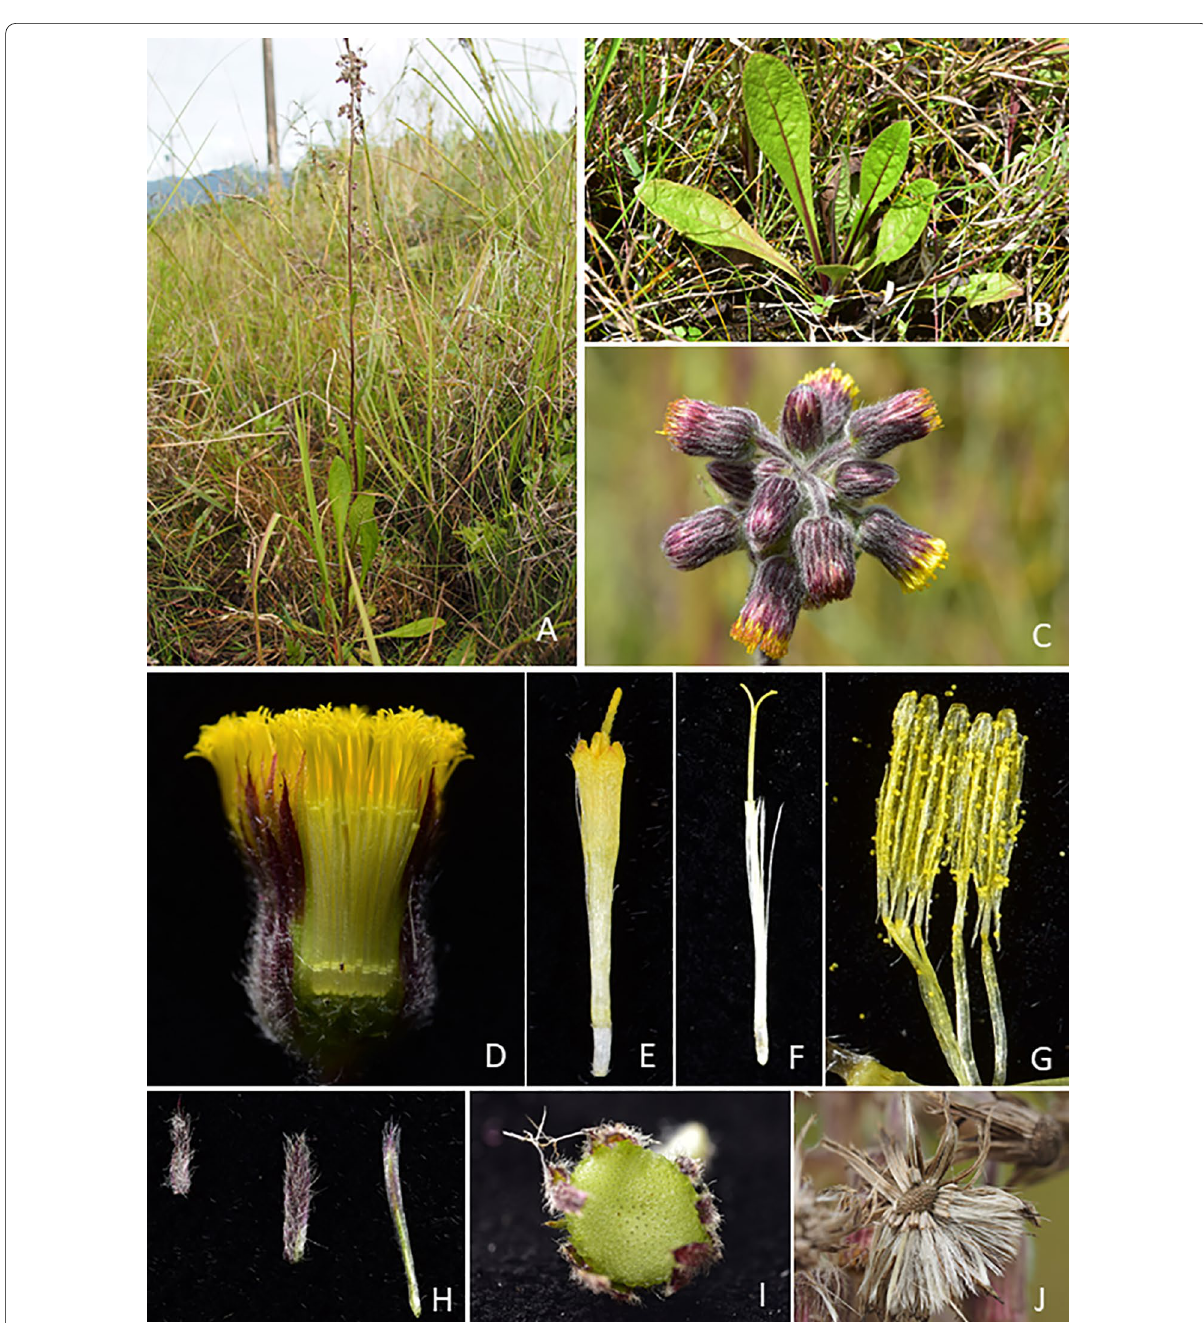
Fig. 1 Blumea chishangensis . A habit; B basal leaves; C portion of inflorescence; D dissected capitula; E central floret; F outer floret; G stamens; H involucral bracts; I receptacle; J receptacle and